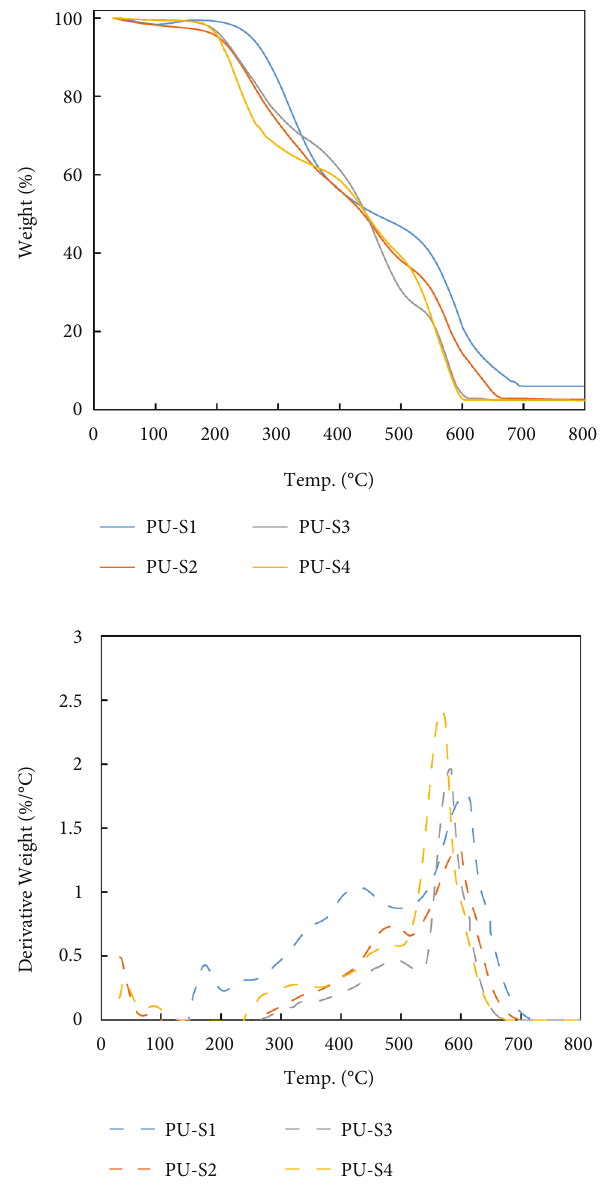
Figure 13: TGA-DTG of PURFs. Table 4: Summary of TGA results for PURFs.